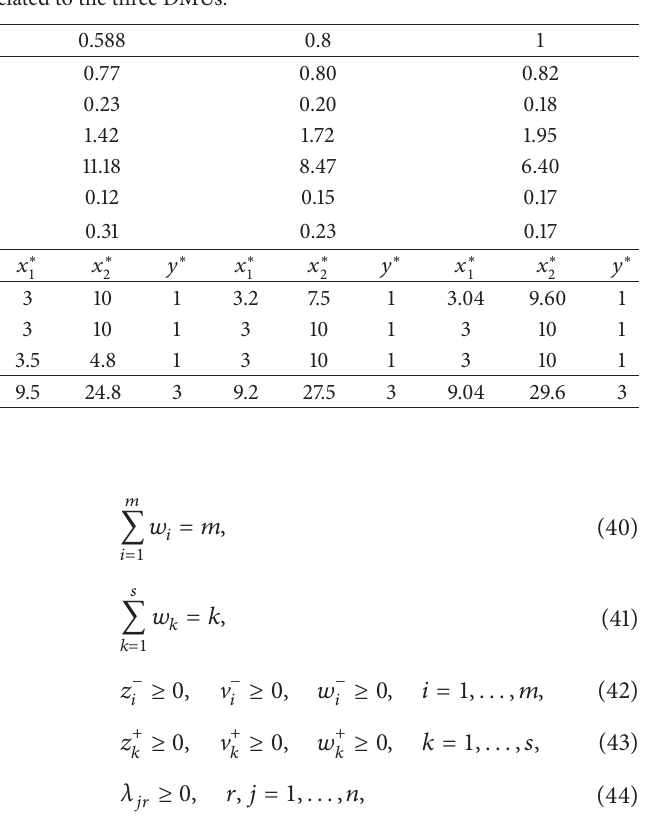
Table 2: The results related to the three